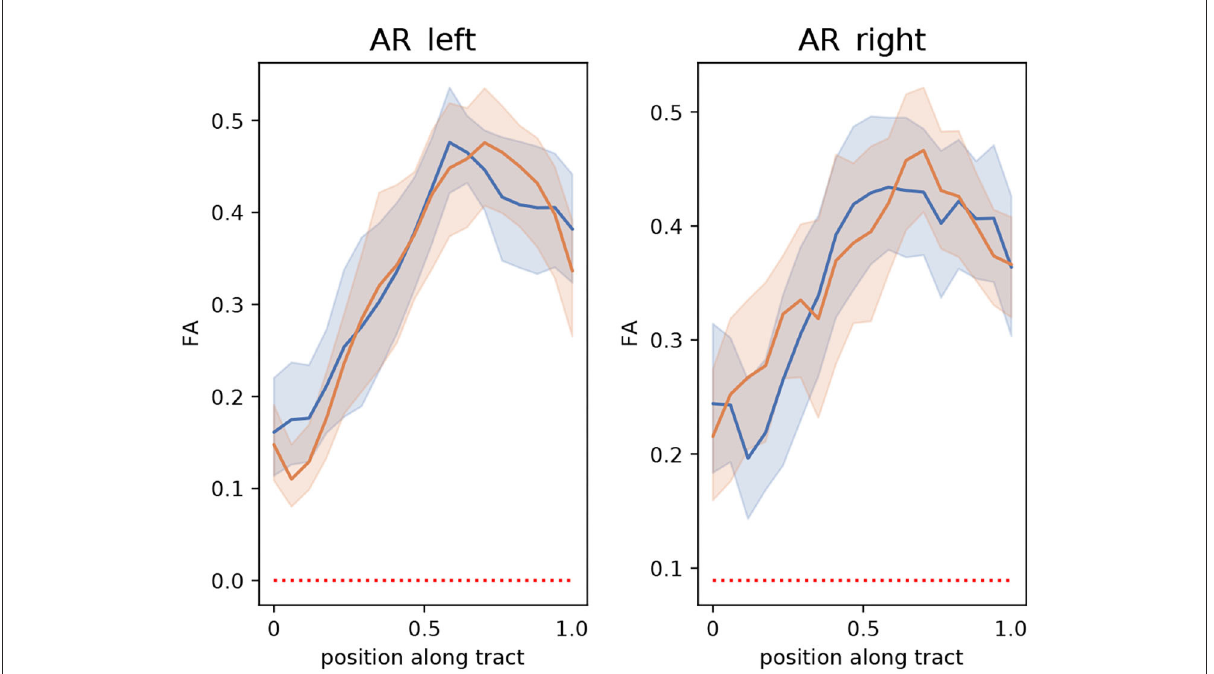
FIGURE9 Bundle analysis of the fractional anisotropy (FA) applied to the left and right acoustic radiations (AR) for the clinical dataset used in this paper. The mean FA of patients and controls along the tracts are shown with lines in blue and orange, respectively. The 95% CIs are shown in light blue and light orange bands, respectively for the two groups. Position 0 and 1 along the tract are located at the medial geniculate nucleus and the Heschl’s gyrus,